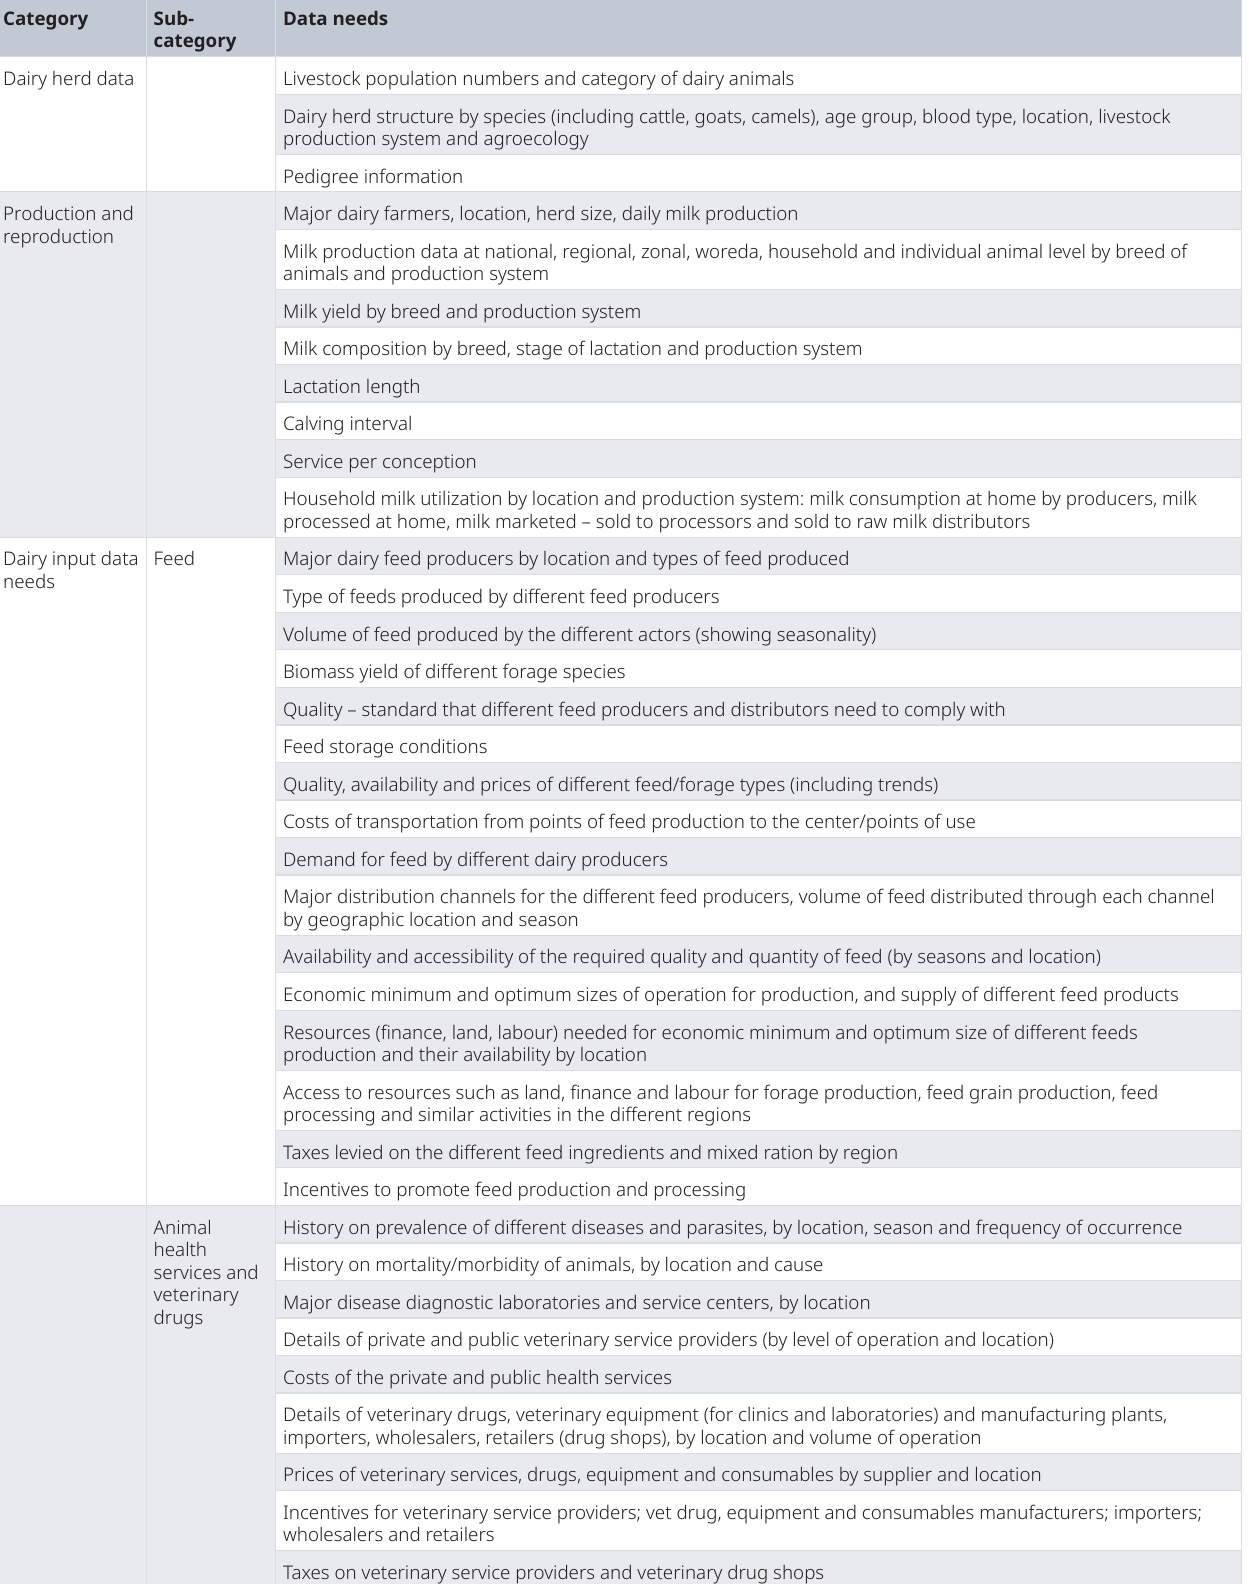
Table 1. Synthesis of data needs by different stakeholder clusters and data categories, grouped under